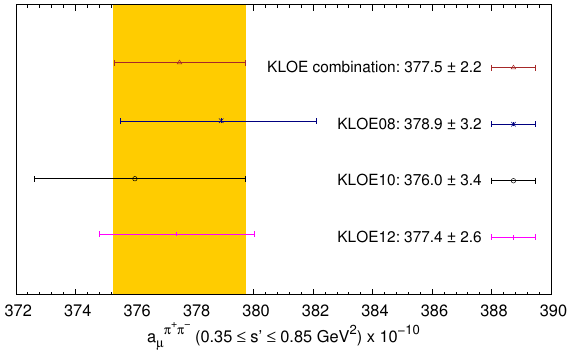
Figure 6. Comparison of estimates of a (cid:25) + (cid:25) (cid:0) from the KLOE combination and the individual (cid:22) KLOE measurements in the range 0 : 35 < s 0 < 0 : 85 GeV 2 . The KLOE combination is represented by the yellow band (colour online). In all cases, the uncertainties shown are the statistical and systematic uncertainties summed in